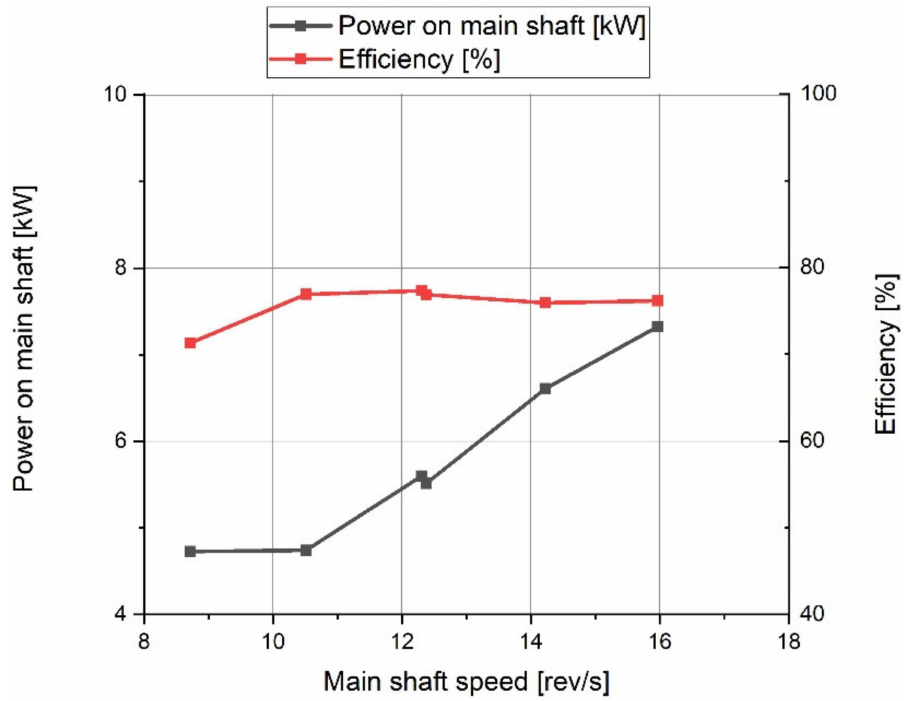
Figure 10. Power and e ffi ciency of the system in electric motor